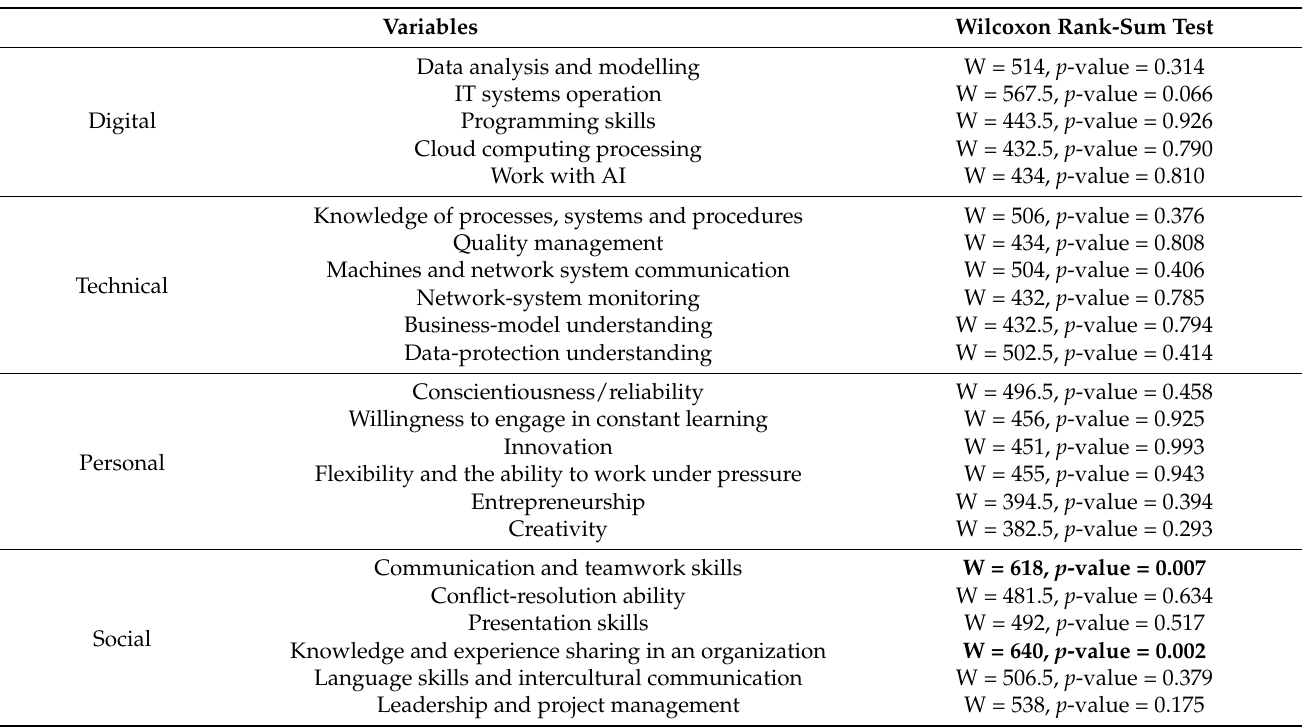
Table 2. The comparison of competency assessments between